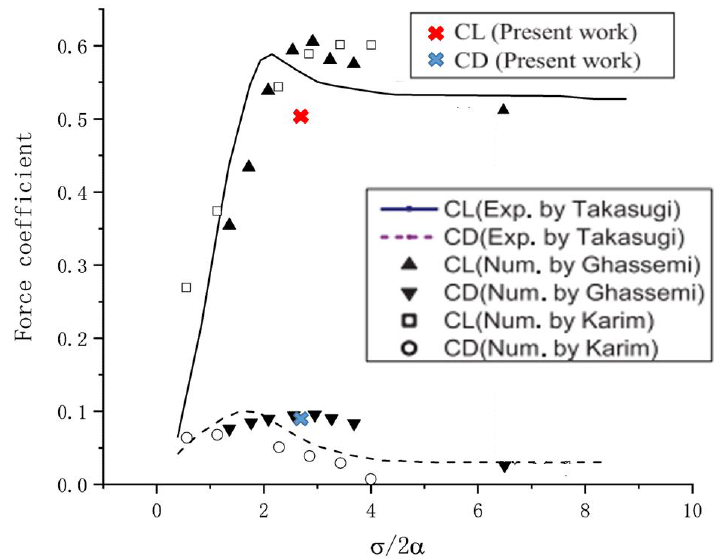
Figure 11. Comparison of the mean lift and drag with experimental and other numerical results.